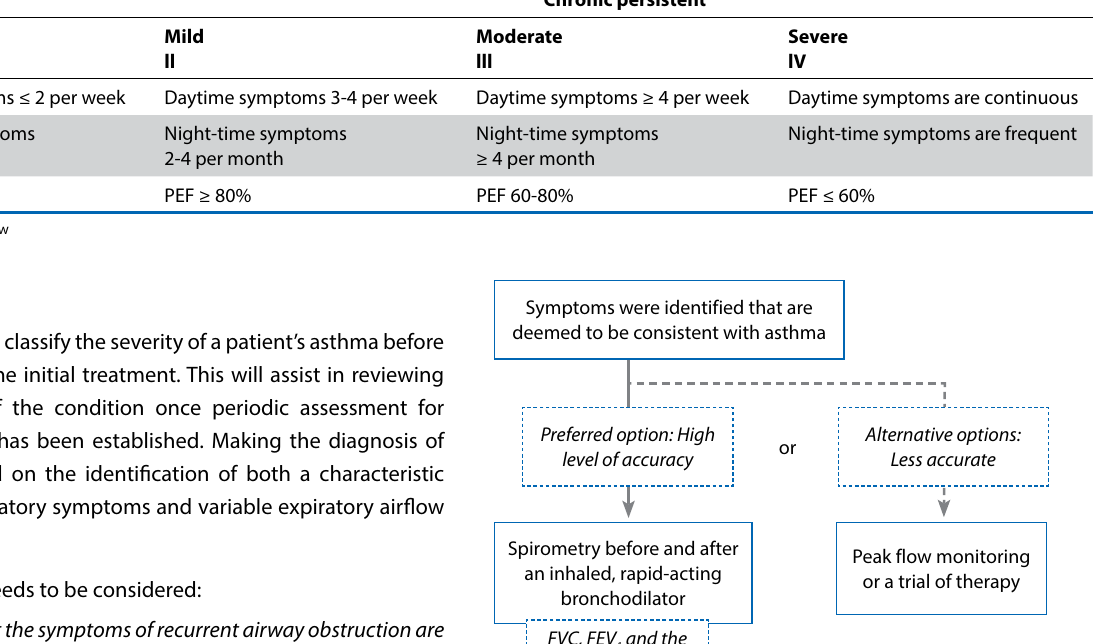
Table II: Classification of asthma severity 11